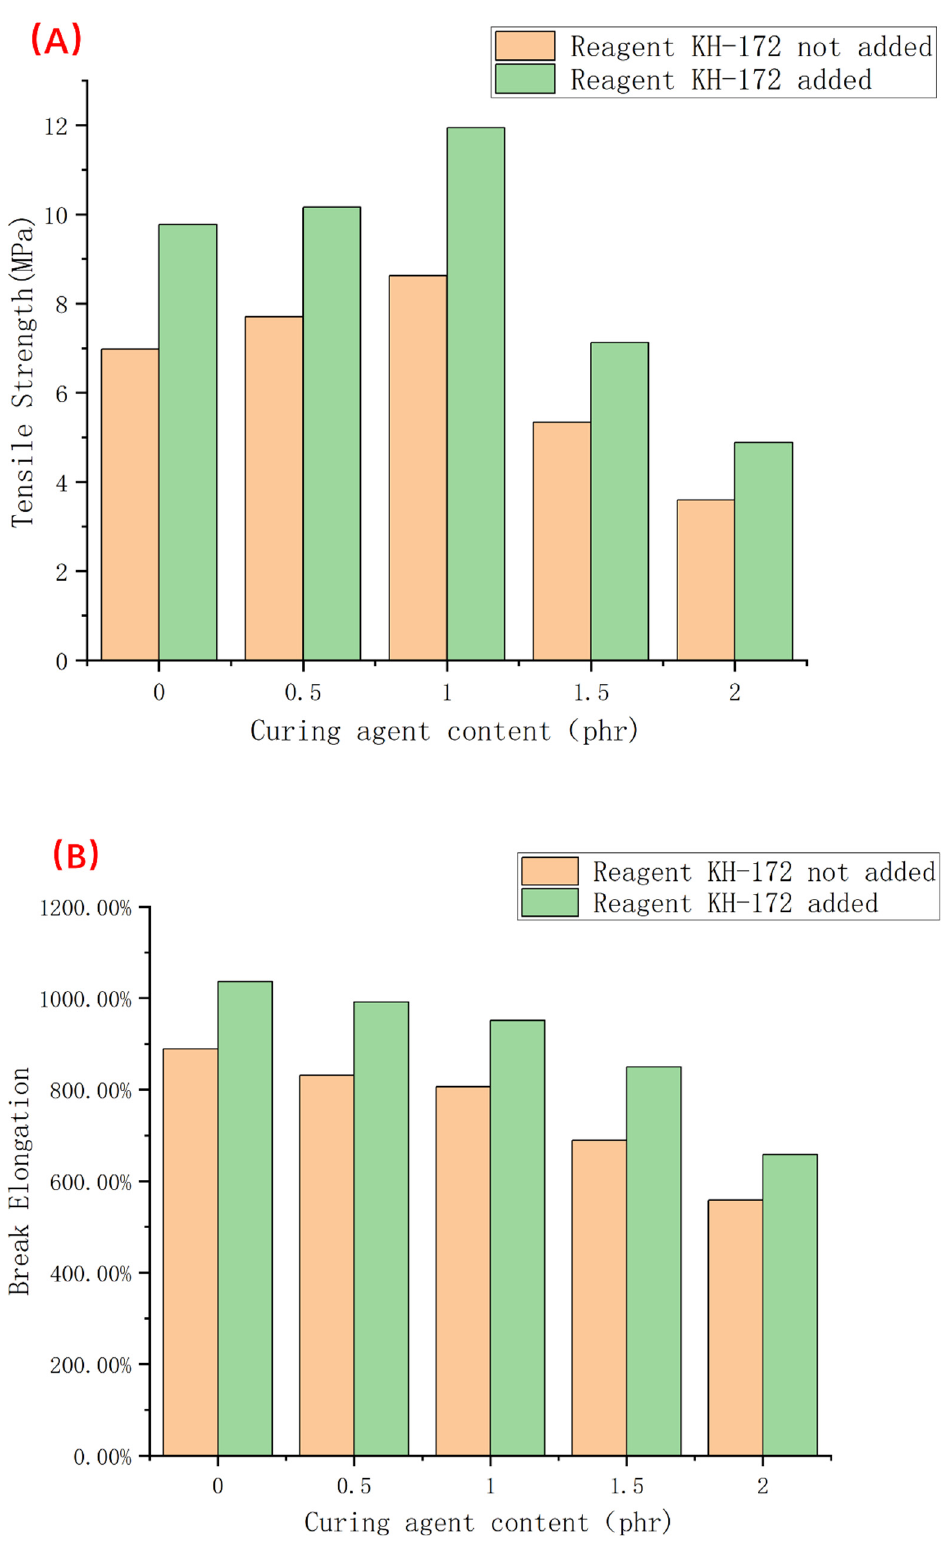
Figure 8. Histogram of tensile strength and elongation at the break of samples 1–5 (( A ) is the change in tensile strength of each group of samples before and after adding KH-172, and ( B ) is the change of elongation at break of each group of samples before and after adding KH-172.).